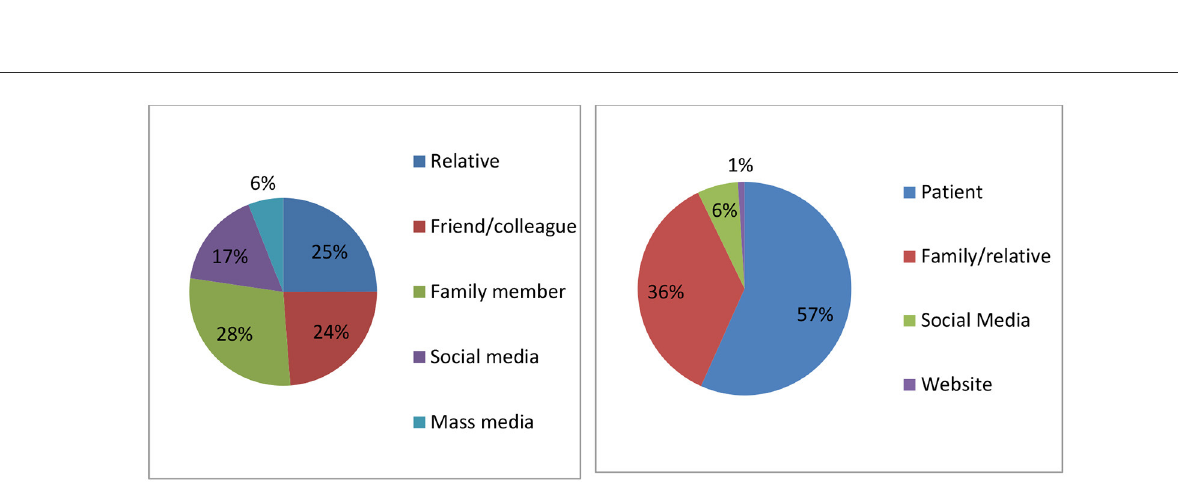
FrontiersinPublicHealth 07